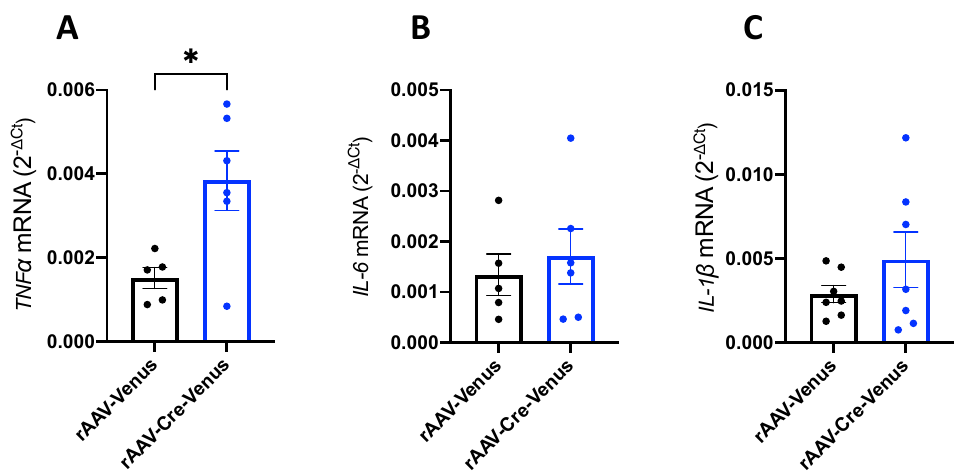
Figure 3. Hippocampal mRNA expression levels of the pro-inflammatory cytokines ( A ) TNF α ; ( B ) IL-6 and ( C ) IL-1 β . Individual data points, and mean value ± SEM are shown. Student’s unpaired t -test. * p <